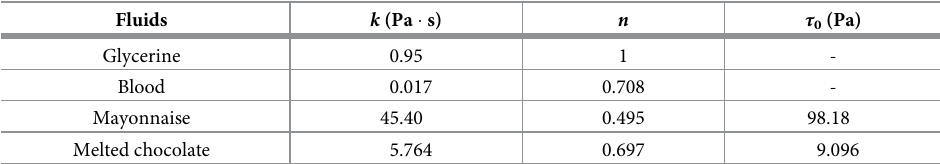
Table 1. Characteristics of the fluids considered in this